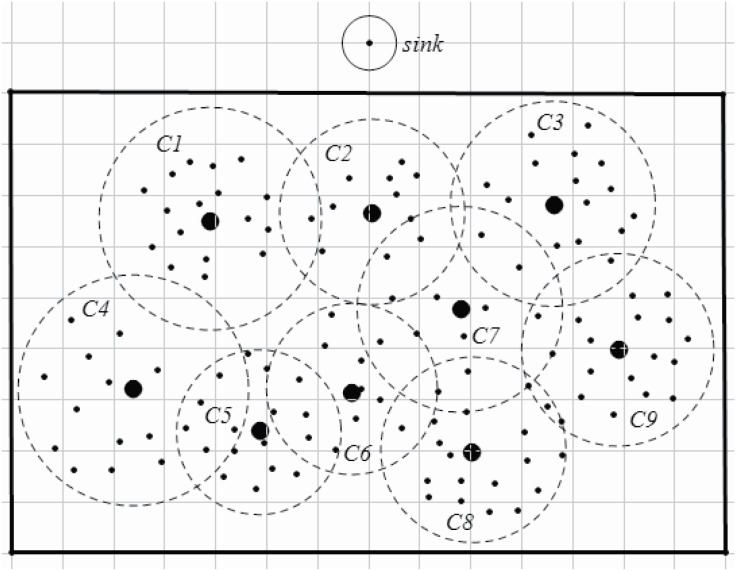
Cluster construction and cluster head selection.